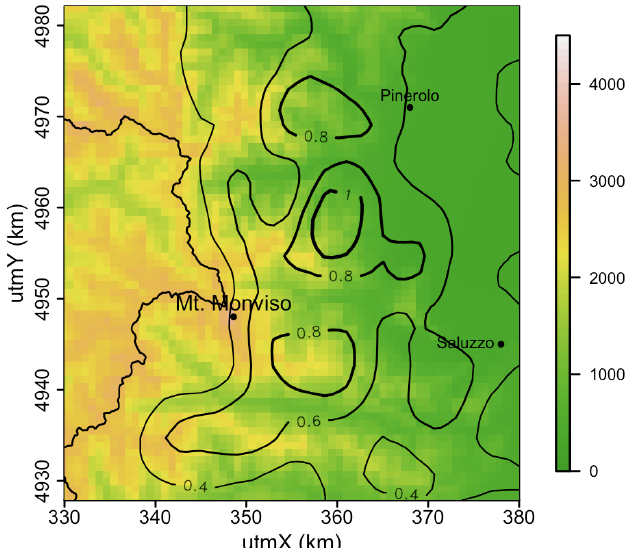
Figure 9. Spatial distribution of IDs density over the Monviso area (contour lines) overplotted over topography (color